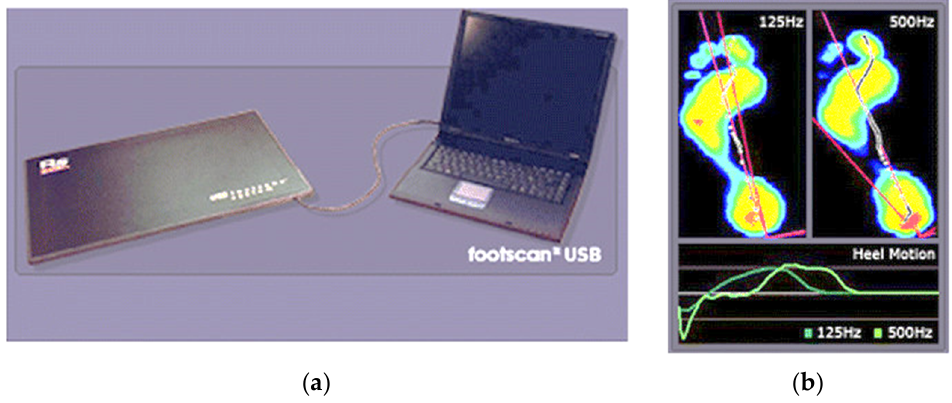
Figure 1. RSscan platform: ( a ) RSscan components; ( b ) RSscan software (Rsscan—RS software for footscan|Logemas).